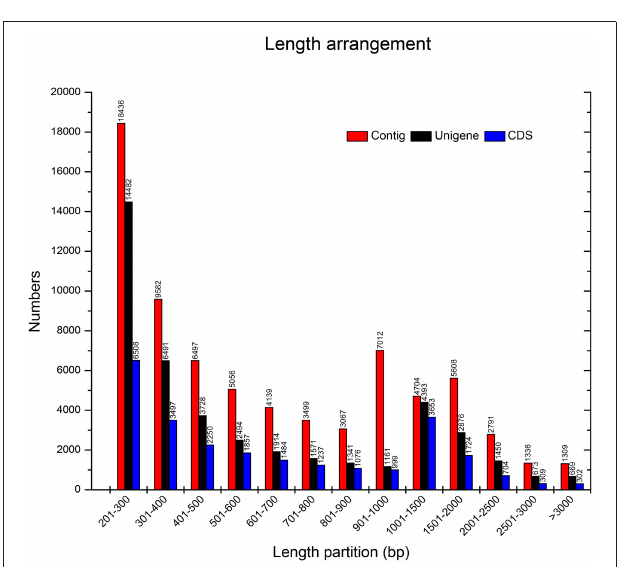
FIGURE 2 | Overview of the D. asperoides transcriptome assembly and the length distribution of the Contigs, Unigenes, and Coding sequences (CDS).